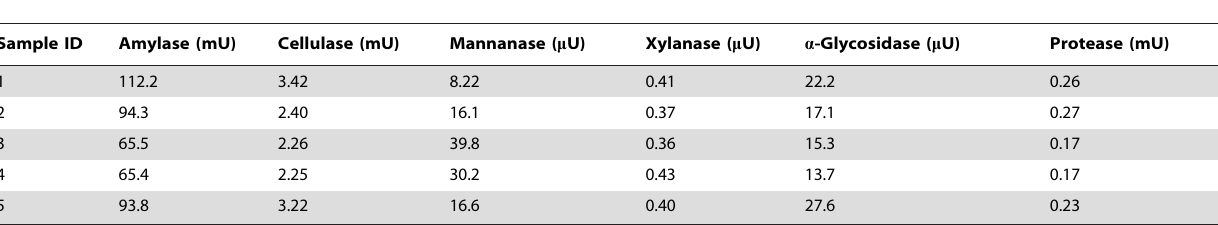
Table 1. The digestive enzymatic activities detected in H. gigas whole-body extracts.